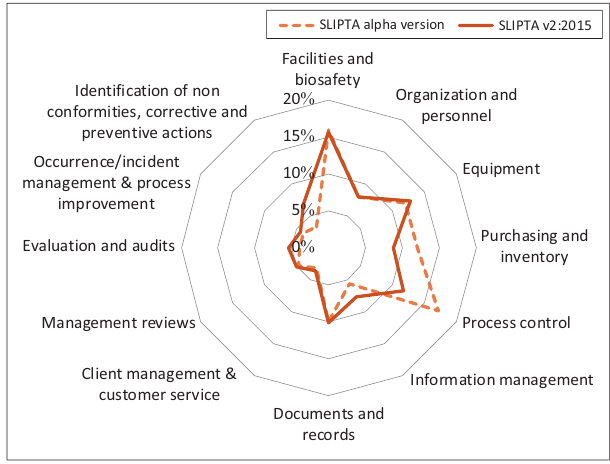
FIGURE 1: Relative point distribution of the scoring system over the different sections of Stepwise Laboratory Quality Improvement Process Towards